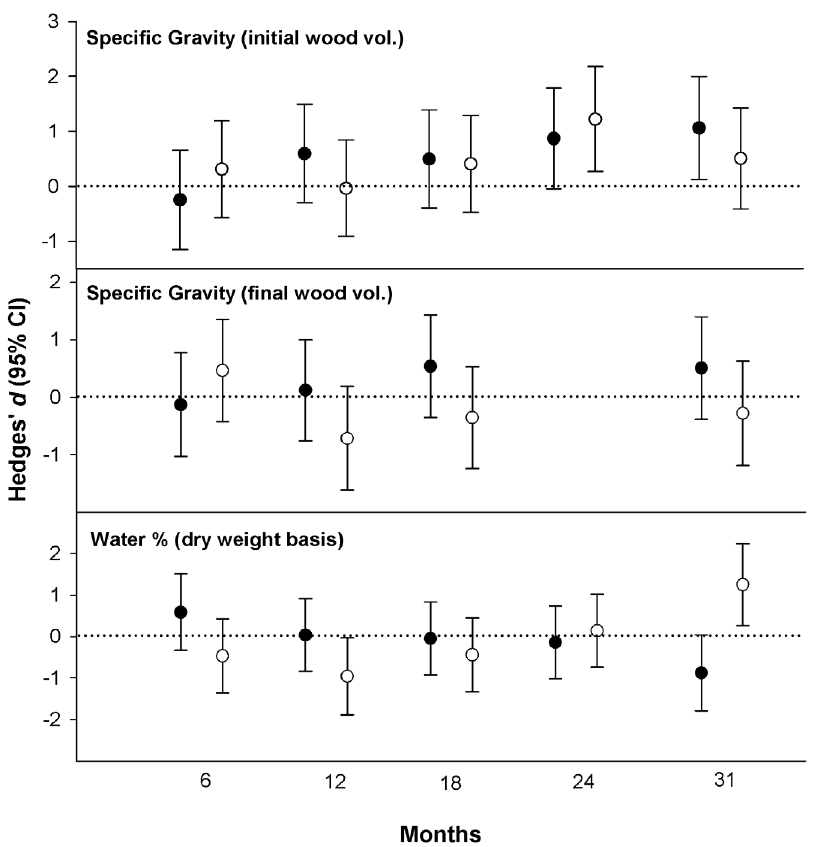
Figure 5. Effect sizes (Hedges’ d 6 95% confidence intervals) for comparisons between protected and unprotected bolts (i.e., protected-unprotected) in flooded (closed circles) and unflooded (open circles) forests. Note: data on specific gravity (final wood volume) were not collected at 24 months.